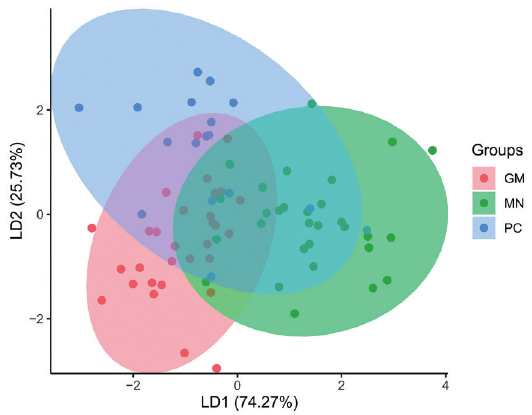
FIGURE 6 | Linear Discriminant Analysis (LDA) of contour shape according to elliptical Fourier descriptors (EFDs). GM = Stellifer gomezi , MN = S. menezesi , PC = S. punctatissimus .